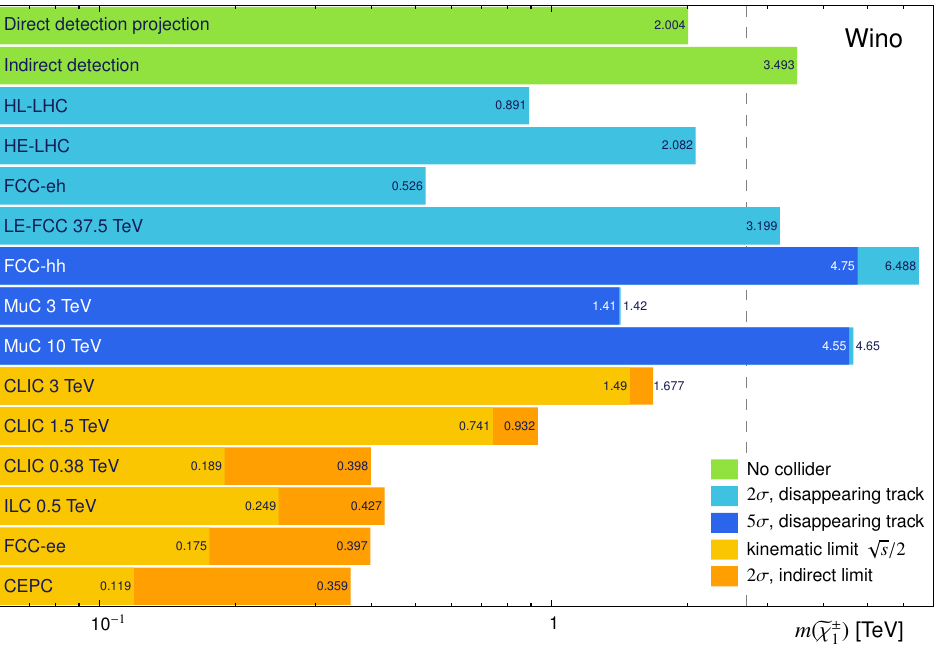
Figure 17. Summary of the sensitivity to pure wino models at future experimental facilities. The results for other facilities are taken from refs. [18,